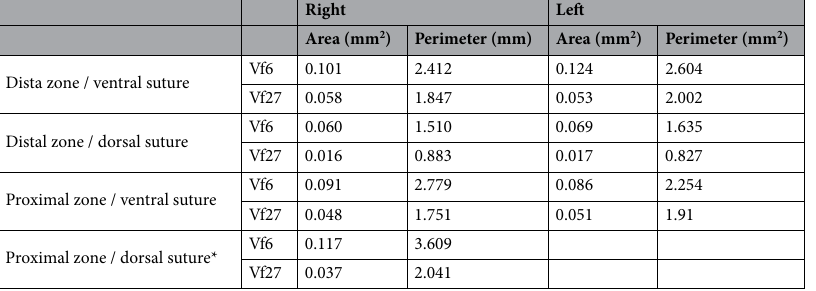
Table 5. Area and perimeter of the sheath lignified layers in the parental lines, measured at the distal and proximal sides of the ventral and dorsal pod sutures. Lignified cells arranged as a single layer without left–right distinction are indicated by an asterisk.